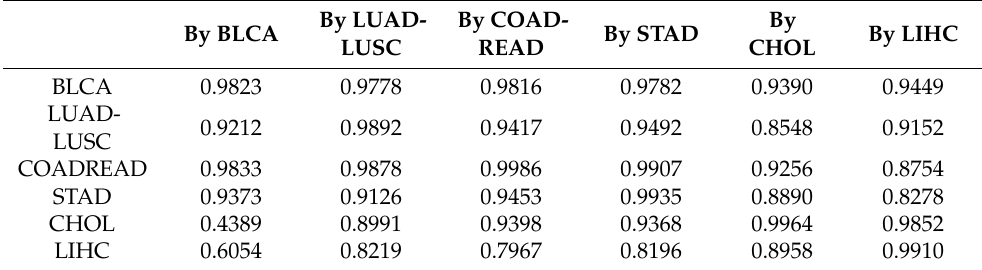
Table 1. Cross-validation results for the TCGA-FFPE slides of the six different cancer types. By By LUAD- By COAD- By LIHC By STAD By BLCA CHOL LUSC READ BLCA